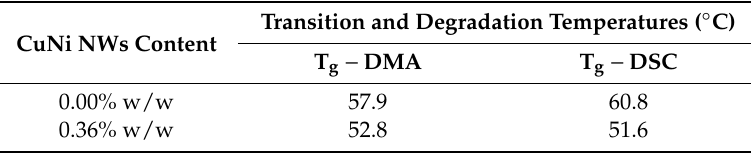
Table 2. Values determined from the DMA, DSC, and TGA